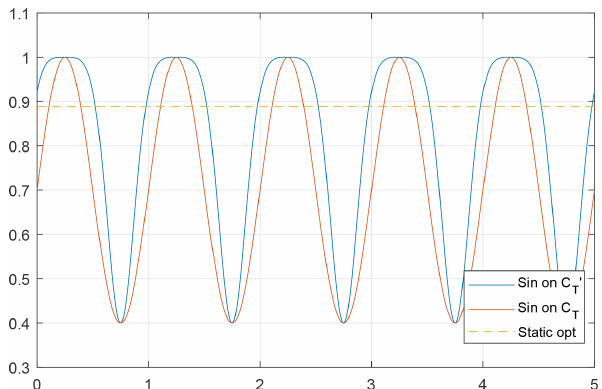
Figure 2. Values of C T for different types of input signals, created using a lookup table of the G1 turbine model. The thrust coefficient is shown for three different sinusoidal excitations: on C T , on C (cid:48) and on the collective pitch angle β , tuned such that the amplitude of C (cid:48) is 1.5. The dashed line shows the steady-state optimal C T T